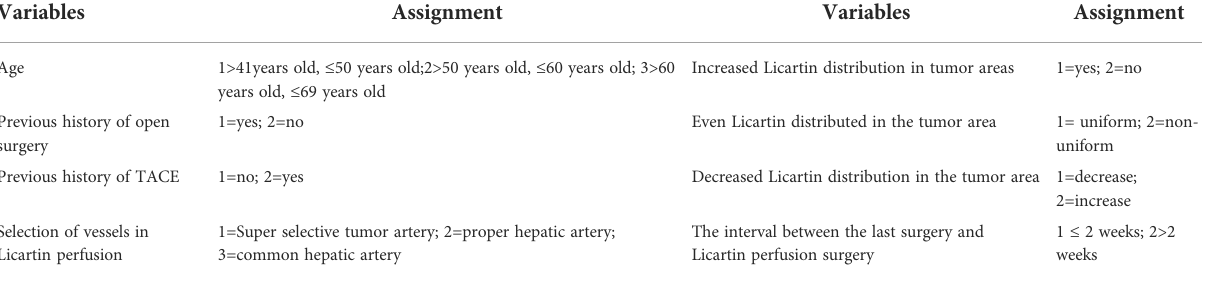
TABLE 1 Assignment table of variables in fl uencing the distribution of Licartin in the region of liver malignancy.